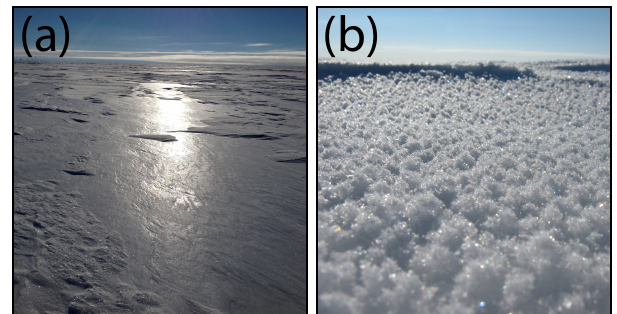
Figure 3. Surface “glaze” (a) that formed on a calm, sunny day (23 December 2012) at WAIS Divide, and the subsequent surface hoar layer (b) that formed on its surface after several calm days.